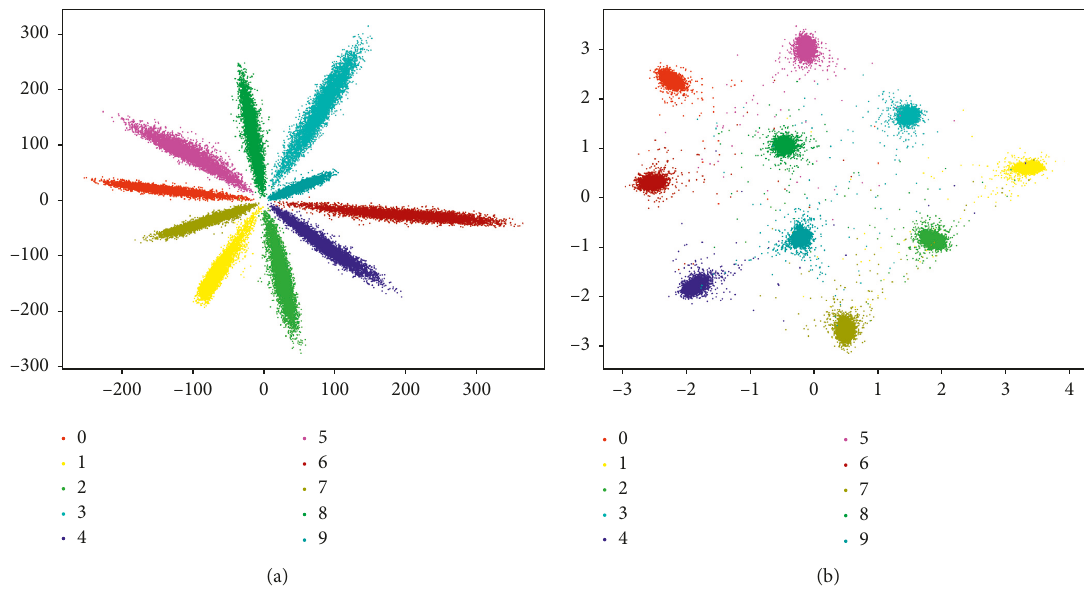
Figure 1: Distributions of the features trained using (a) soft-max and (b) GO loss on MNIST. Each color represents a class. The GO loss has better intraclass compactness and interclass separation than traditional soft-max loss. Best viewed in